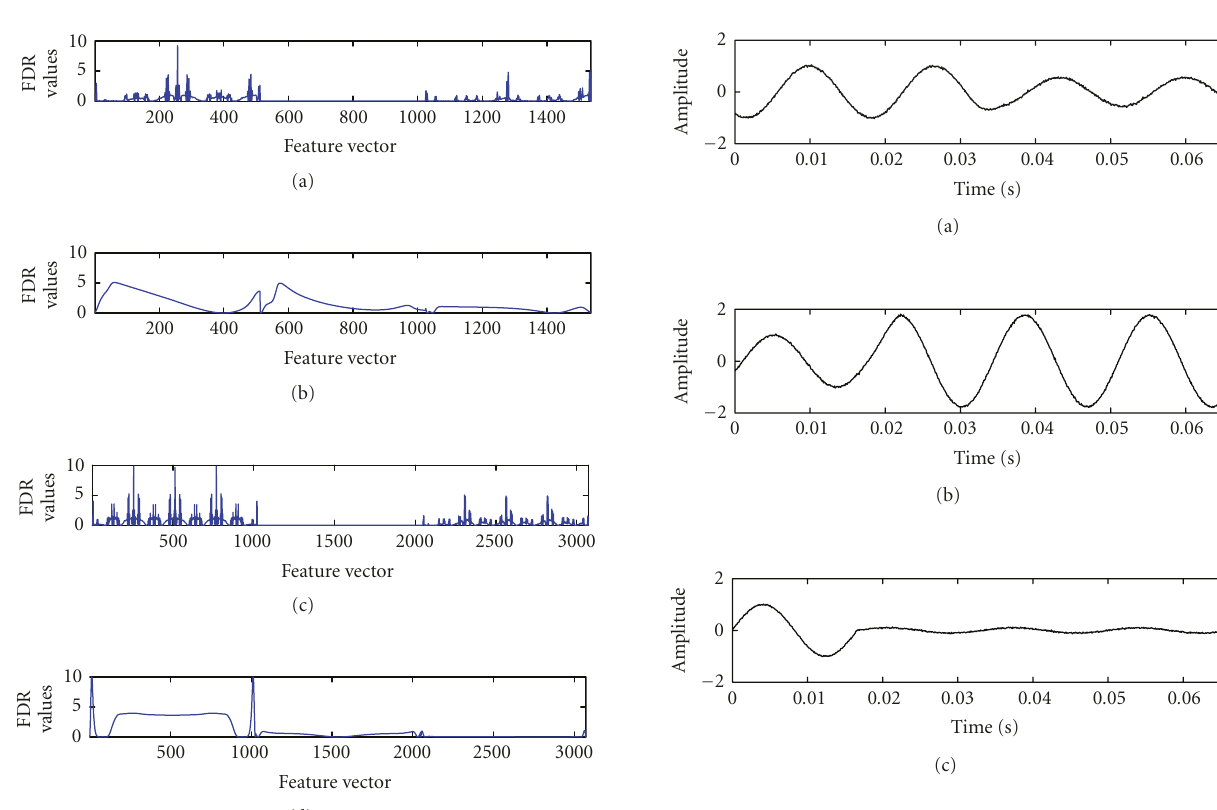
Figure 15: Typical single disturbances related to vector f . (a)–(c) are samples of disturbances called sag, swell, and interruptions, re- , (c) (cid:21) c u , and (d) (cid:21) c u or or